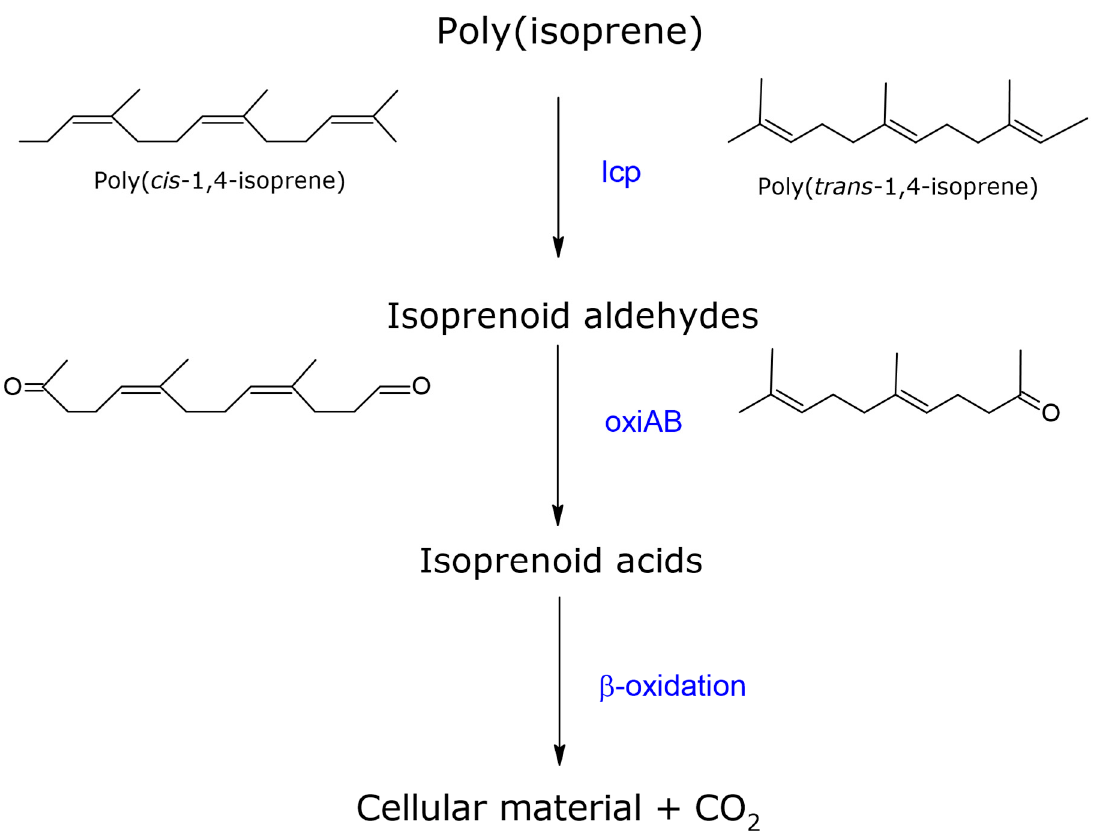
Figure 4. Schematic diagram representing the primary steps of poly(isoprene) biodegradation, followed by oxidization for aldehydes to the corresponding acids, which can be further metabolized via ß-oxidation. Abbreviations: lcp, latex clearing protein; oxiAB, isoquinoline 1-oxidoreductase subunit alpha and